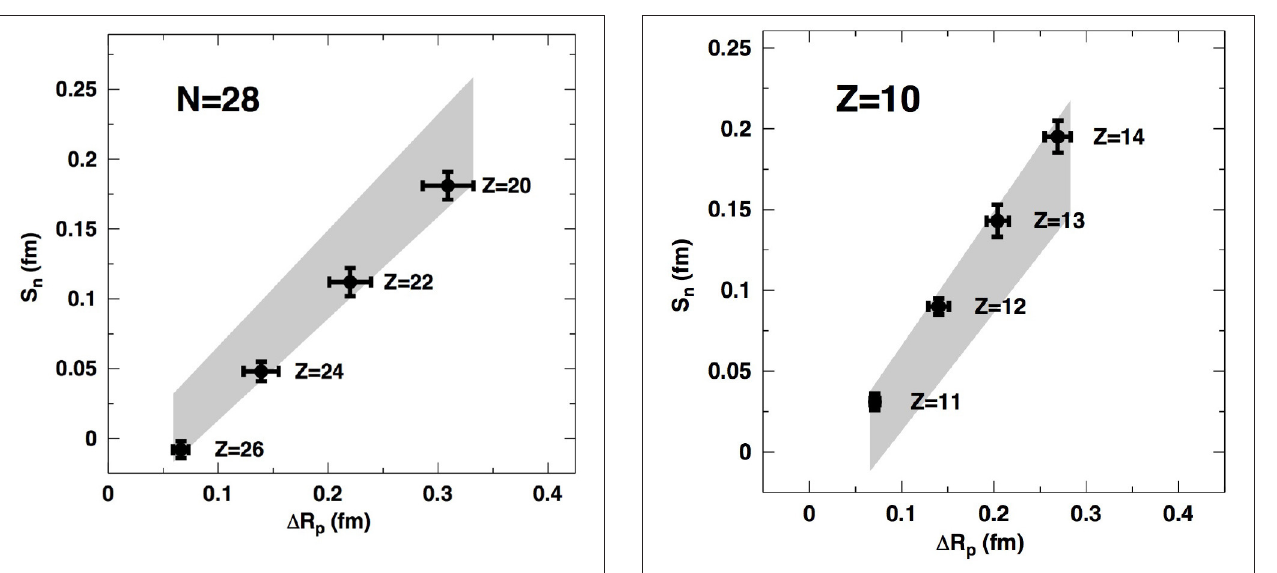
FIGURE 4 | As in Figure 2 but for Table 6